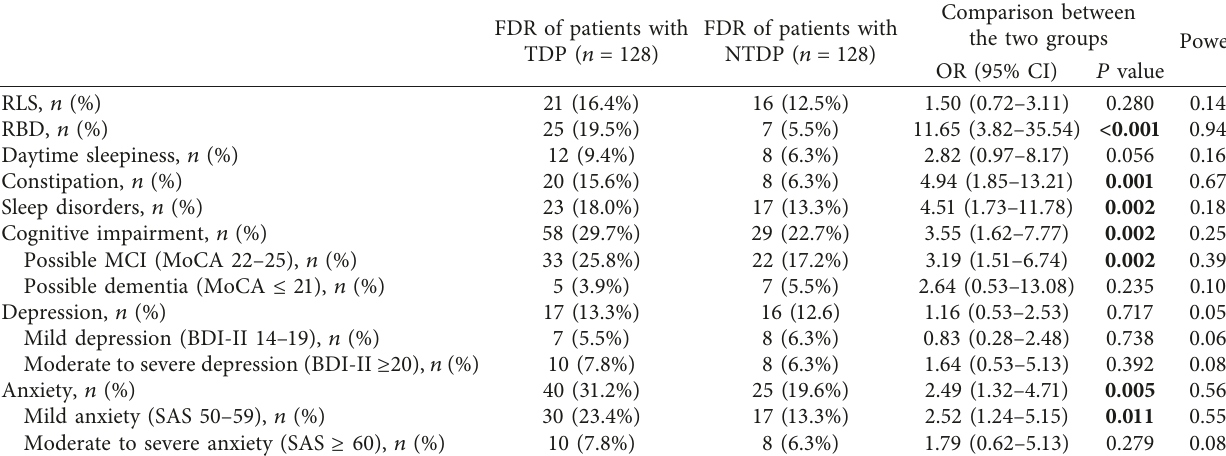
Table 4: Comparison of NMS between the FDR groups of TDP and NTDP.